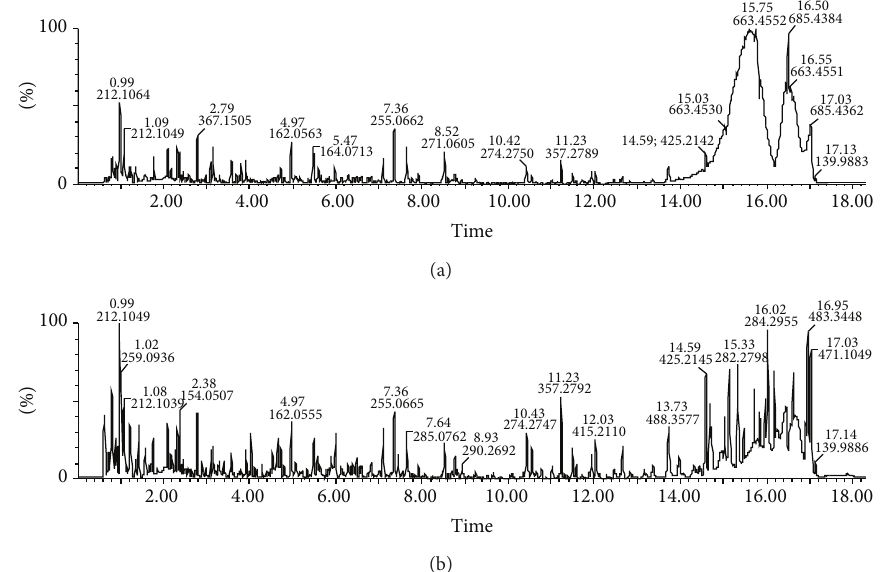
Figure 1: Base peak intensity (BPI) chromatograms obtained from the positive ion UPLC-MS analyses of control (a) and diet-induced hyperlipidemia (b) rats.